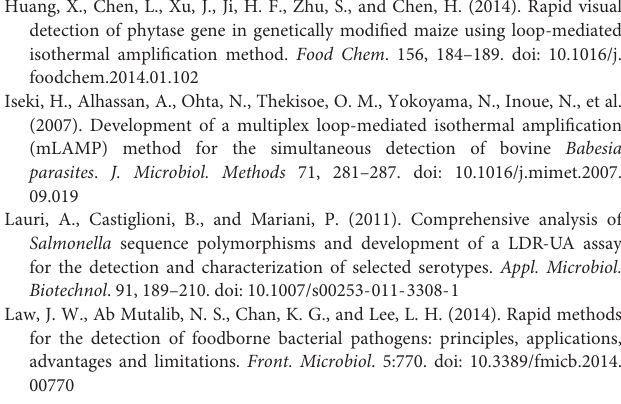
FIGURE S1 | Bacteriostatic experiment and titer of anti-Shigella serum by ELISA. (A–C) Represent inoculation of 50 uL · 10 8 cfu/mL, 10 6 cfu/mL, and 10 4 cfu/mL of Shigella , respectively; (D–F) represent inoculation of 50 uL · 10 8 cfu/mL, 10 6 cfu/mL, and 10 4 cfu/mL of Shigella plus 2 uL negative serum, respectively; (G–I) represent inoculation of 50 uL · 10 8 cfu/mL, 10 6 cfu/mL, and 10 4 cfu/mL of Shigella plus 2 uL of antiserum, respectively. (J) presents the titer of mice serum at different dilution ratios as determined by ELISA. FIGURE S2 | Specificity and sensitivity of the ipaH-PCR assays using the genome of Shigella strains and the plasmid containing the ipaH gene of Shigella strains. (a) 1% agarose gel electrophoresis of the Shigella -templated PCR product; lane 1, 2000 bp DNA marker; lane 2, positive PCR products; lane 3 to lane 7 represent the genome of Escherichia coli, Staphylococcus aureus, Salmonella, Listeria , and Pseudomonas aeruginosa PCR products, lane 8 nuclease-free water as a negative